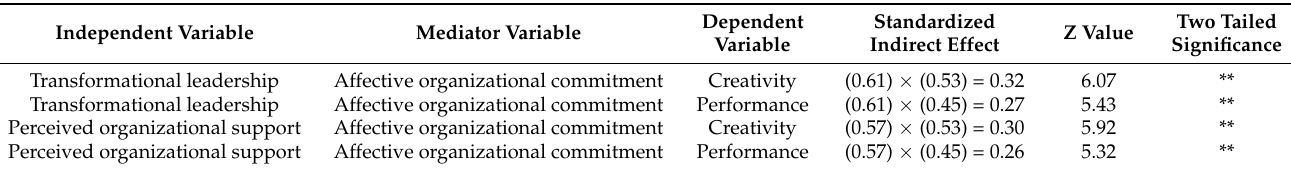
Table 4. Sobel tests of the statistical significance of indirect